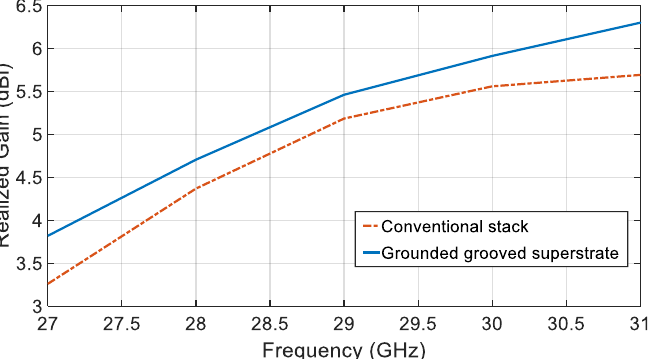
Figure 9. Realized gain profile for the single element CDRA for the two proposed stack over the operational frequency.